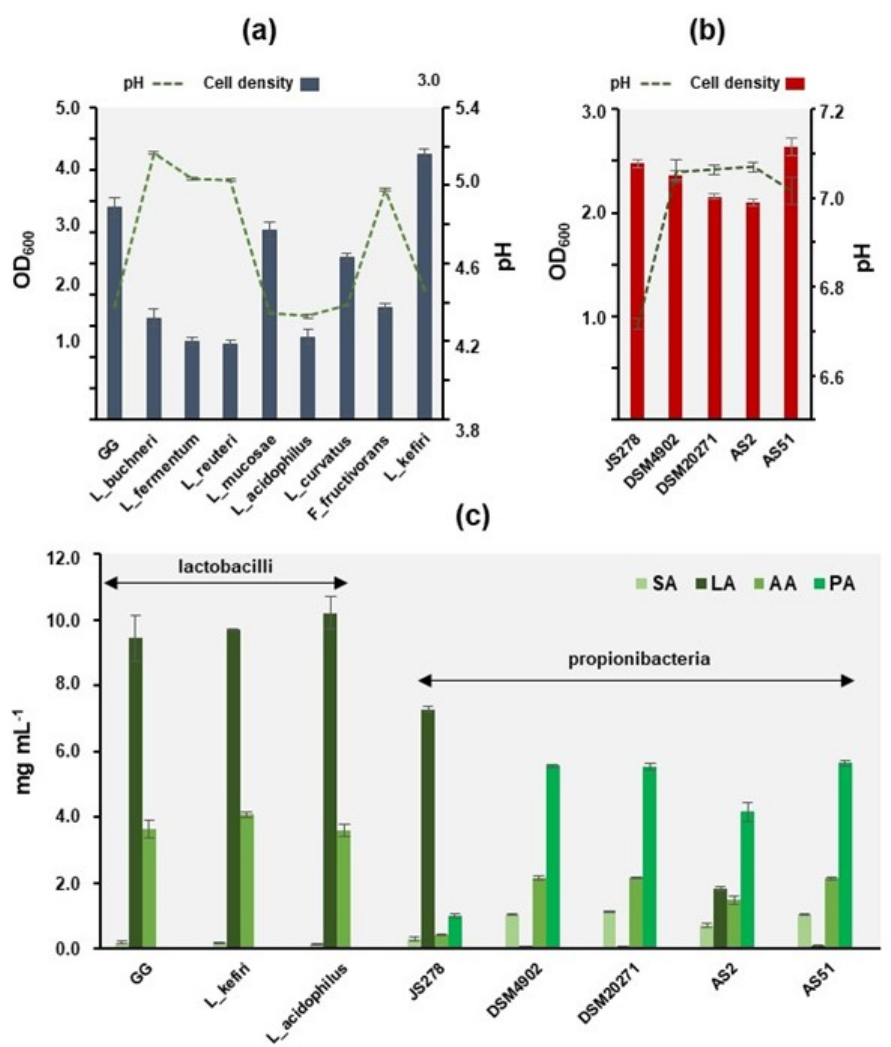
Figure 6. Cell density of the selected lactobacilli ( a ) and propionibacteria ( b ) at the timepoint of sample withdrawal and pH of the cell-free culture supernatants. ( c ) Concentration of key metabolic end-products secreted by the indicated lactobacilli and propionibacteria. SA, succinate; LA, lactate; AA, acetate; PA, propionate. Error bars ± SD ( n = 4).